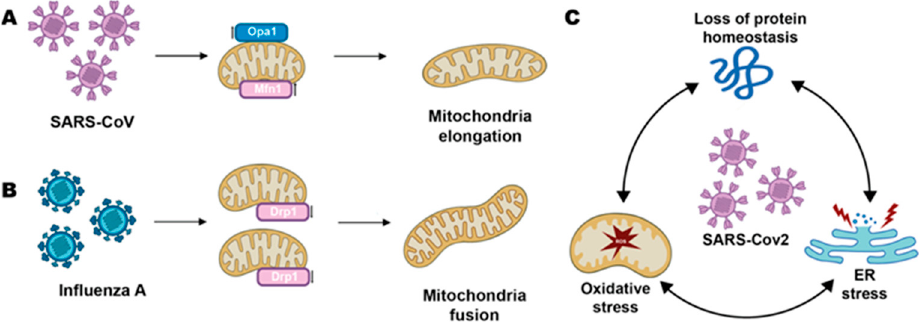
Figure 1. Viruses can impair fusion and fission of neuronal mitochondria via direct interaction with their proteins ( A , B ) or indirectly, via oxidative/ER stress ( C ). Examples are reported in Sections 2–4.